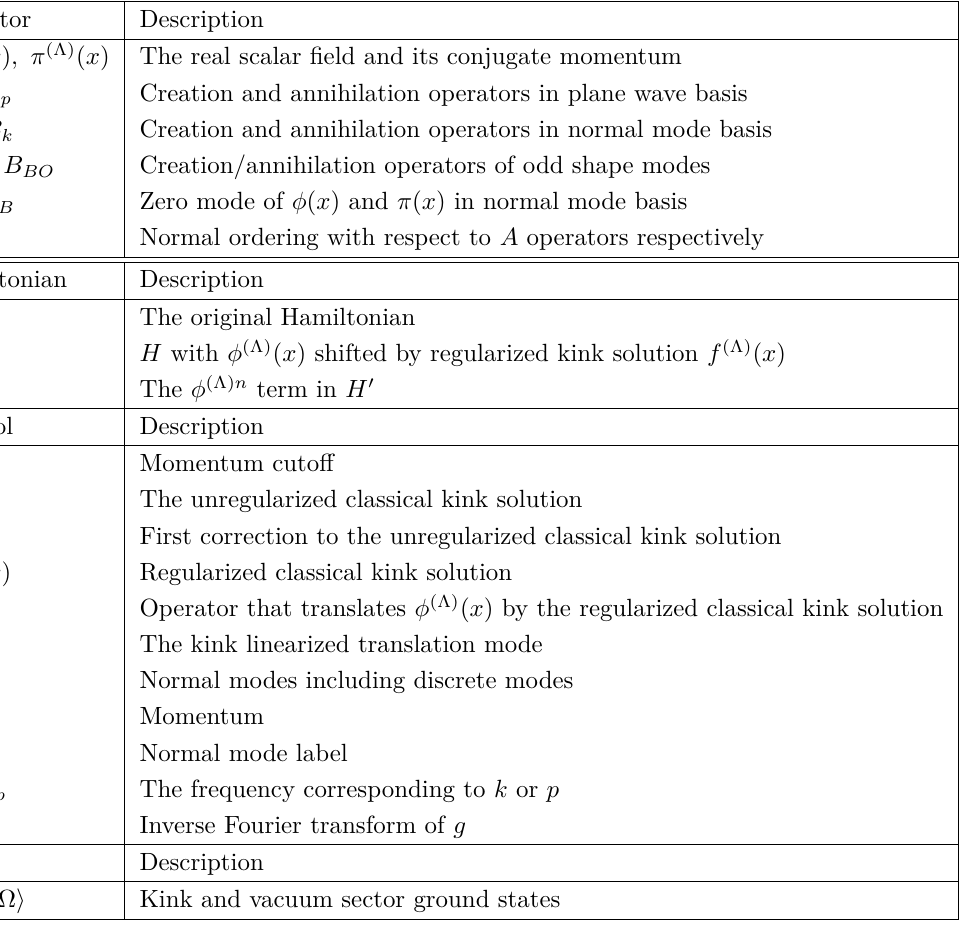
Table 1 . Summary of